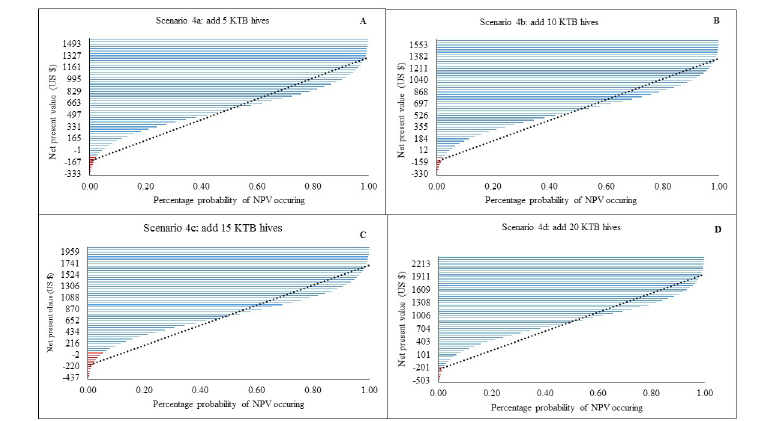
Fig 5. Modelled probability (%) changes in Net Present Value (NPV) for KTB hive numbers (scenarios 4a-d). Income changes following addition of log hives. Red lines indicate loss and blue lines profit. Dotted black line is a linear forecast. NPVs to the right of the line indicate optimal profit/loss attained for each an intervention level.